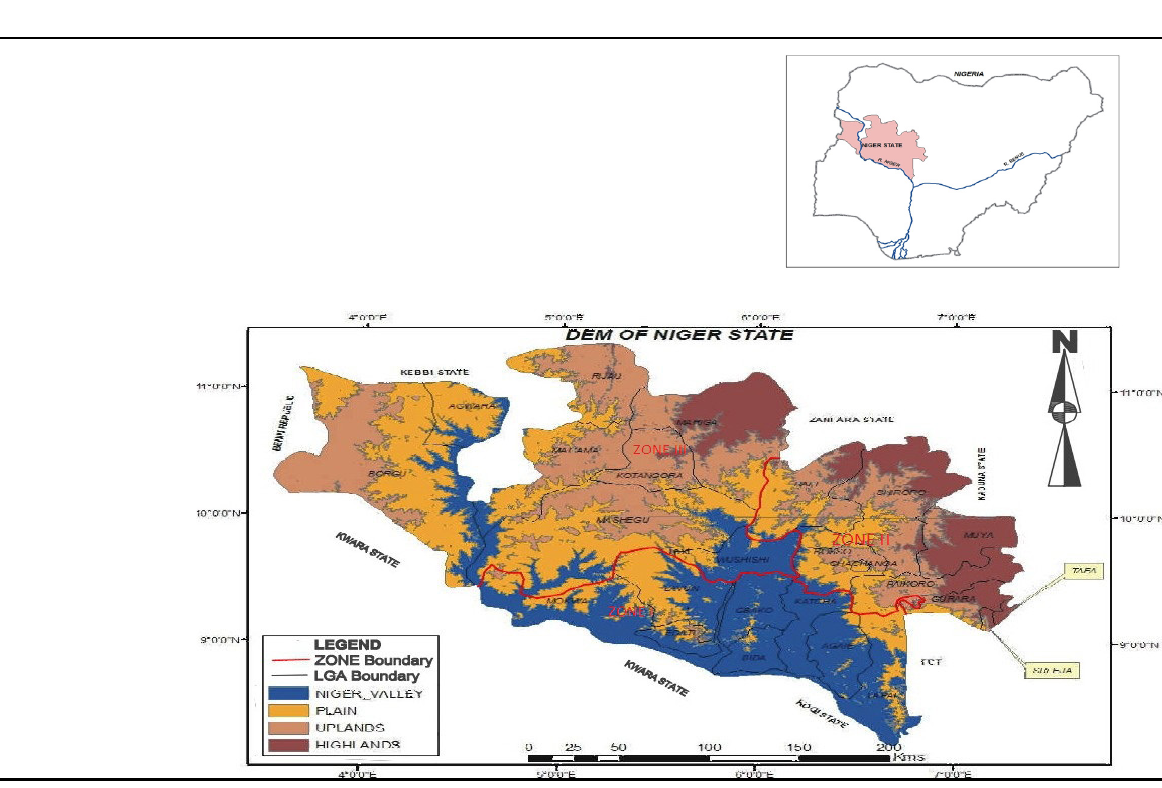
Figure 1 : Digital Evaluation Model (Map) of Niger State. Source: Modified of Ikusemoran et al.